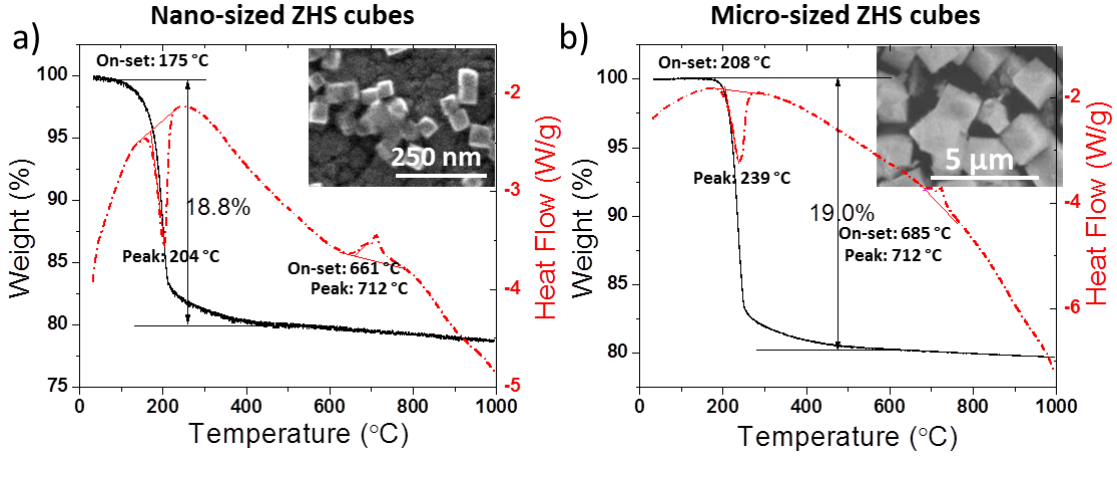
Figure 17. SEM image and TGA/DSC curves for nano-sized ZHS cubes ( a ) and micro-sized ZHS cubes ( b